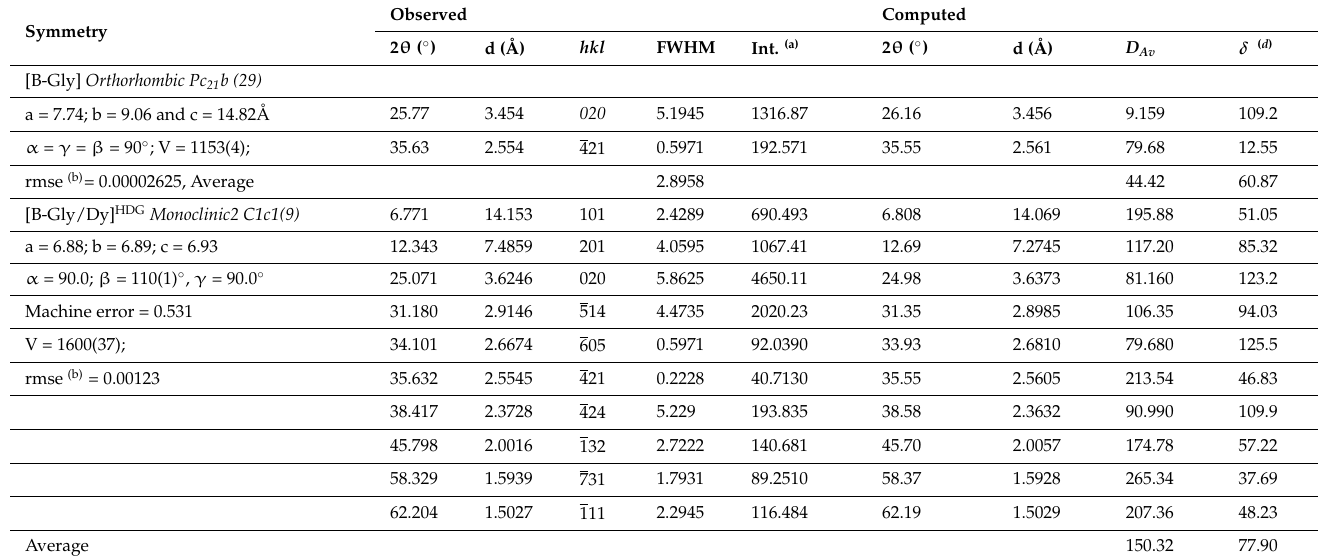
Figure 2. ( a ) PXRD patterns (combined experimental and simulated) for [B-Gly] and [B-Gly] Iso isolate molecule. Insert is a 3D orthorhombic Pc 21 b (29) lattice-type computed using the Polymorph method. ( b ) [B-Gly/Dy] HDG and [B-Gly/Dy] Iso isolate molecule. Inset is a 3D Monoclinic P-1(2) lattice type. Table 1. The experimental and calculated XRD data using the Refine Version 3.0 (Carnegie Mellon University, Pennsylvania) Software Program ( Kurt Barthelme’s & Bob Downs ) for experimental [B-Gly] and [B-Gly/Dy] HDG and simulated parts [B-Gly] Iso and [B-Gly/Dy] Iso